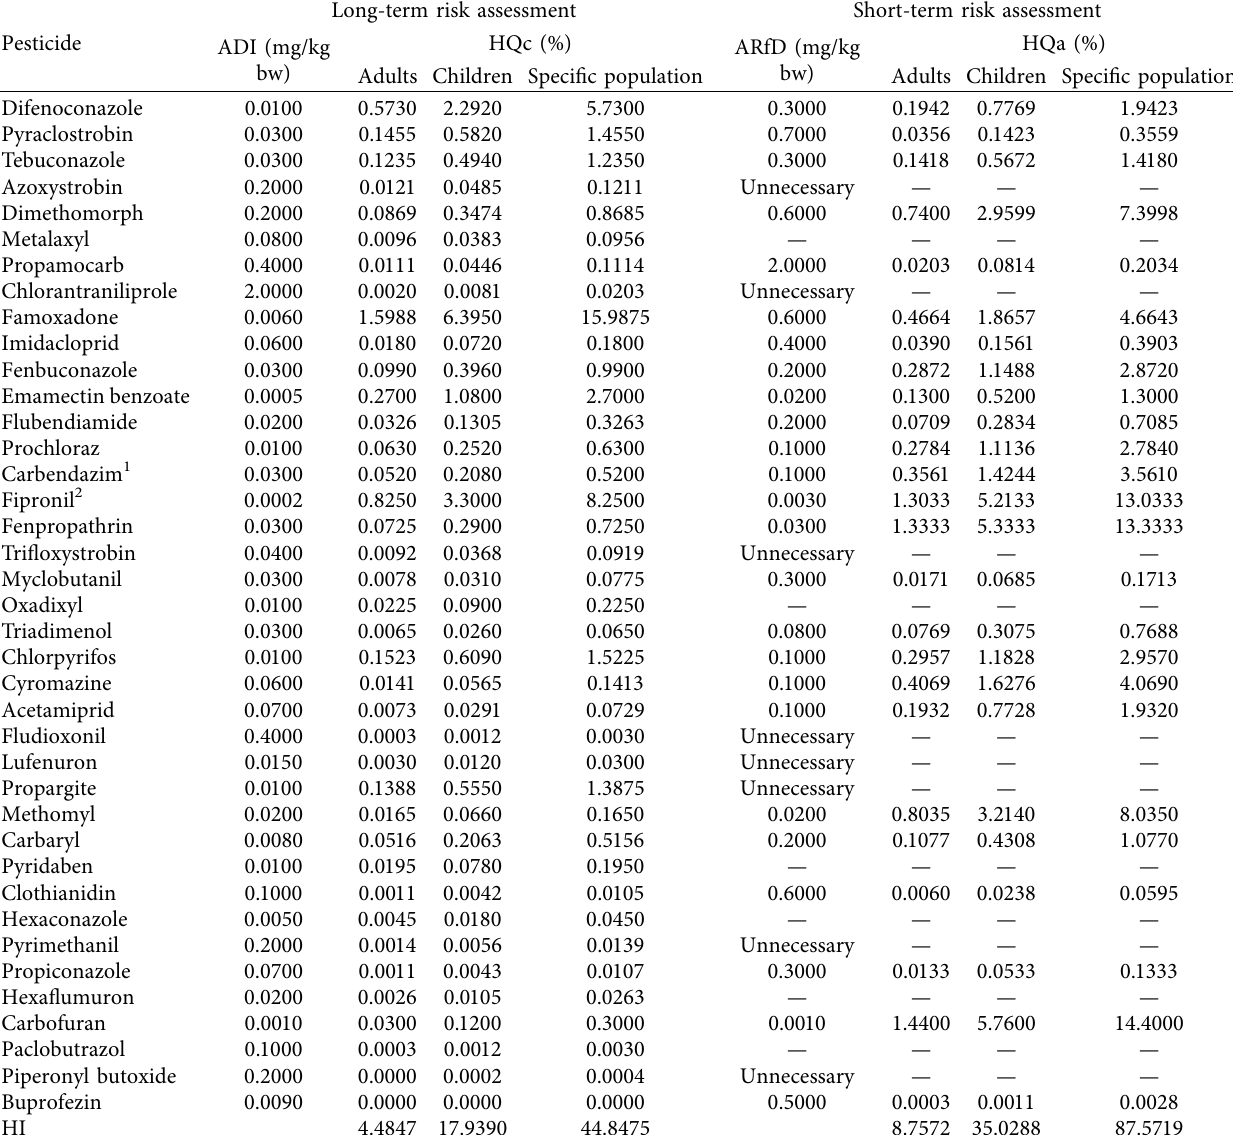
Table 3: Results of the chronic, acute, and cumulative exposure risk for children, adults, and the specific population.